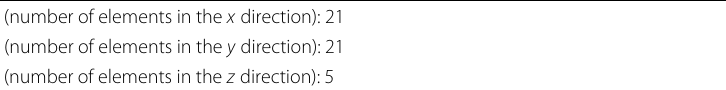
Table 8 Coarse FEM mesh